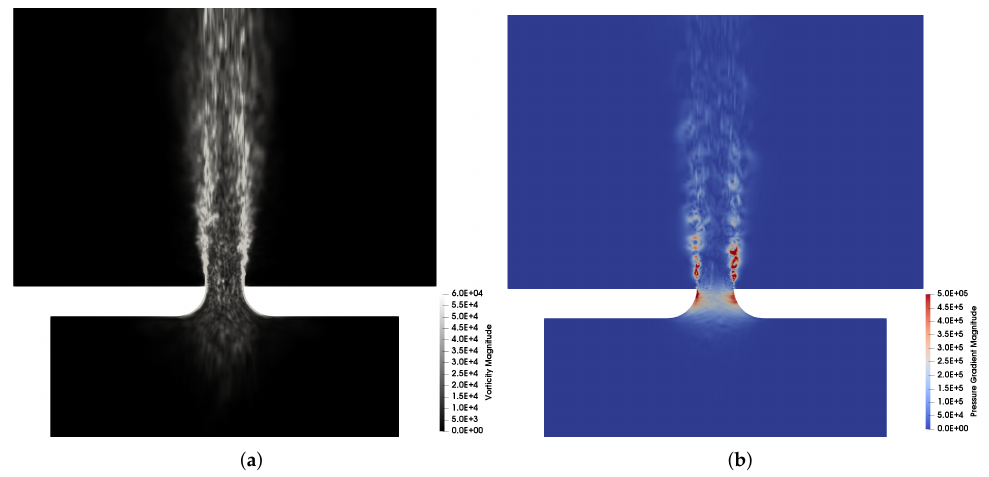
Figure 8. Contours of the vorticity magnitude (calculated using the instantaneous velocity field) showing the unsteadiness not only in the vicinity of the orifice in the shear layers as expected but also in the central potential flow region of the jet. Contours of the pressure gradient magnitude are also plotted to identify regions susceptible to the appearance of cavitation bubbles, which could lead to high transient stresses on nearby surfaces when these bubbles collapse. ( a ) Vorticity magnitude contours. ( b ) Pressure gradient